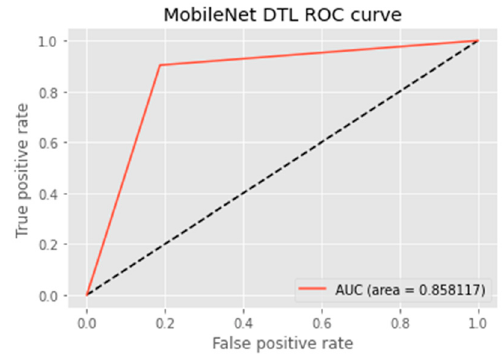
Figure 14. ROC curve of the MobileNet model .